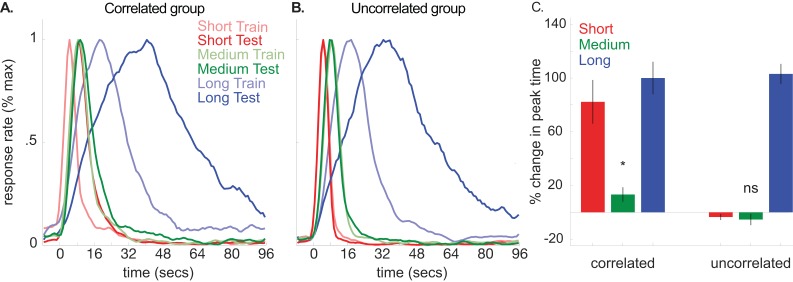
A and B show probe trial responding during initial training and testing for each cue in the correlated (n = 5) and uncorrelated (n = 5) groups of Experiment 4a, respectively.(C) shows percent change in peak time at test (±SEM) for both groups and all cues, relative to initial training.10.7554/eLife.38790.021Figure 5—figure supplement 1—source data 1.Data used to generate Figure 5—figure supplement 1.